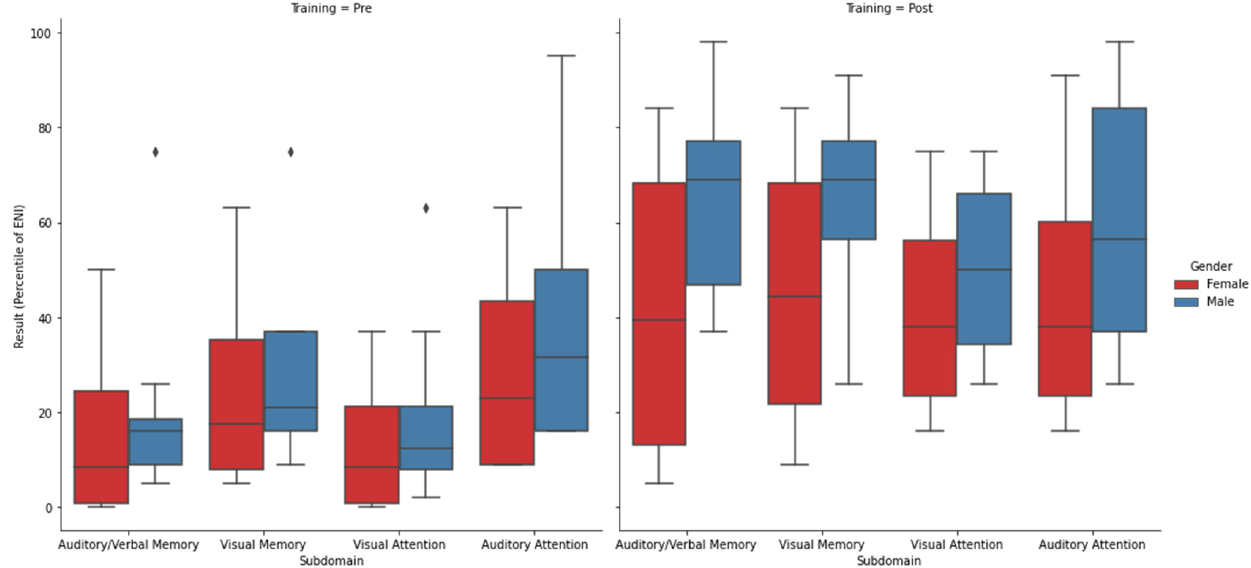
Figure 6. Differences between gender for results of phase I and phase III.